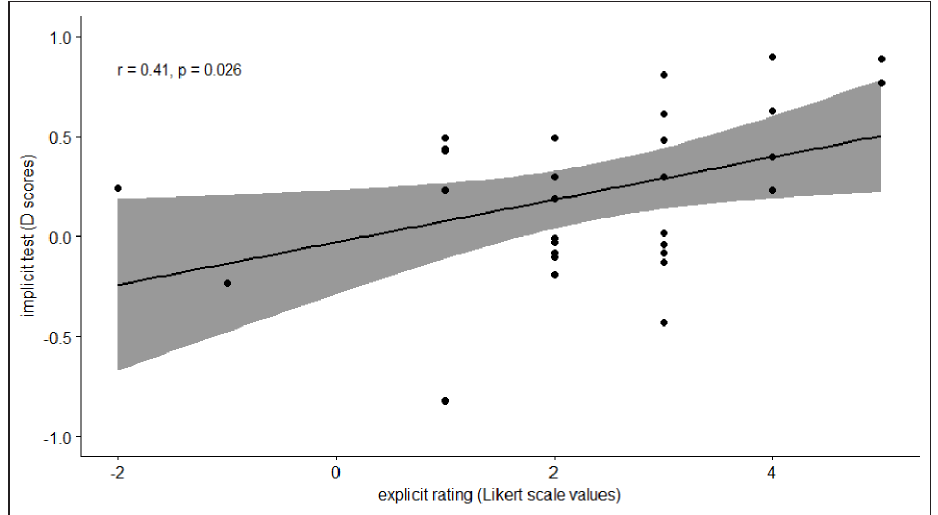
Figure 1: Correlation between the implicit test (D score) and the explicit task (Likert scale